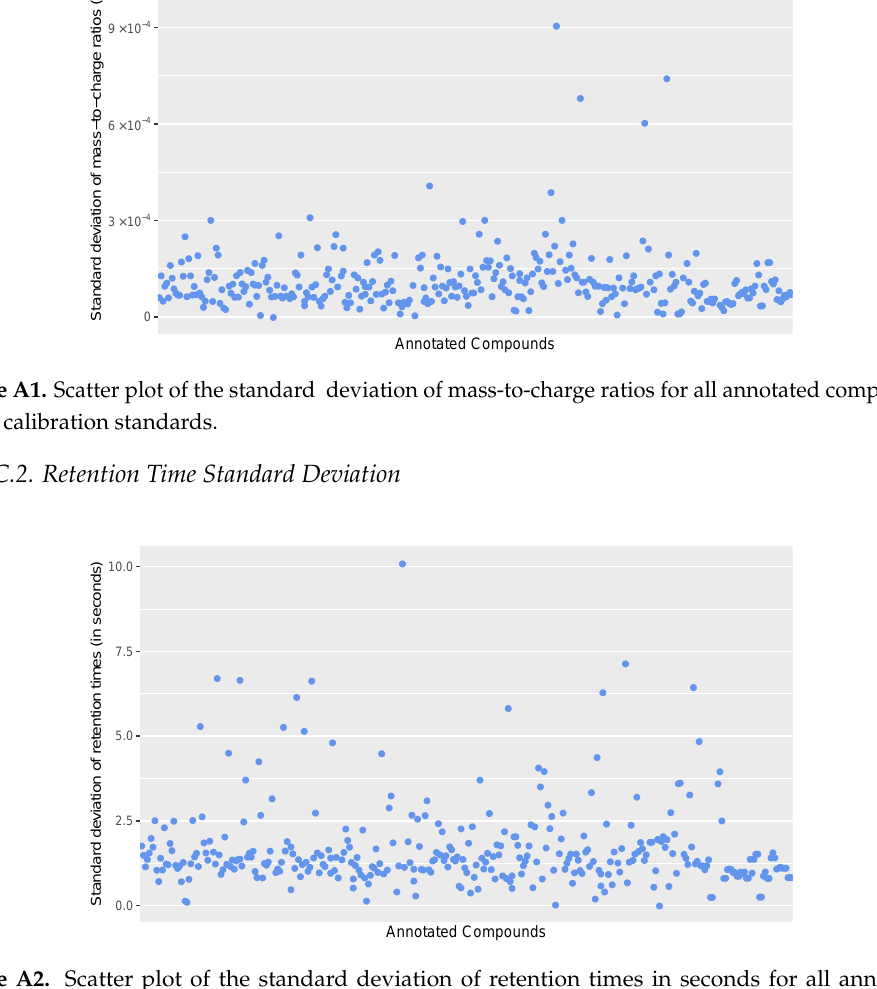
Figure A2. Scatter plot of the standard deviation of retention times in seconds for all annotated compounds in the calibration